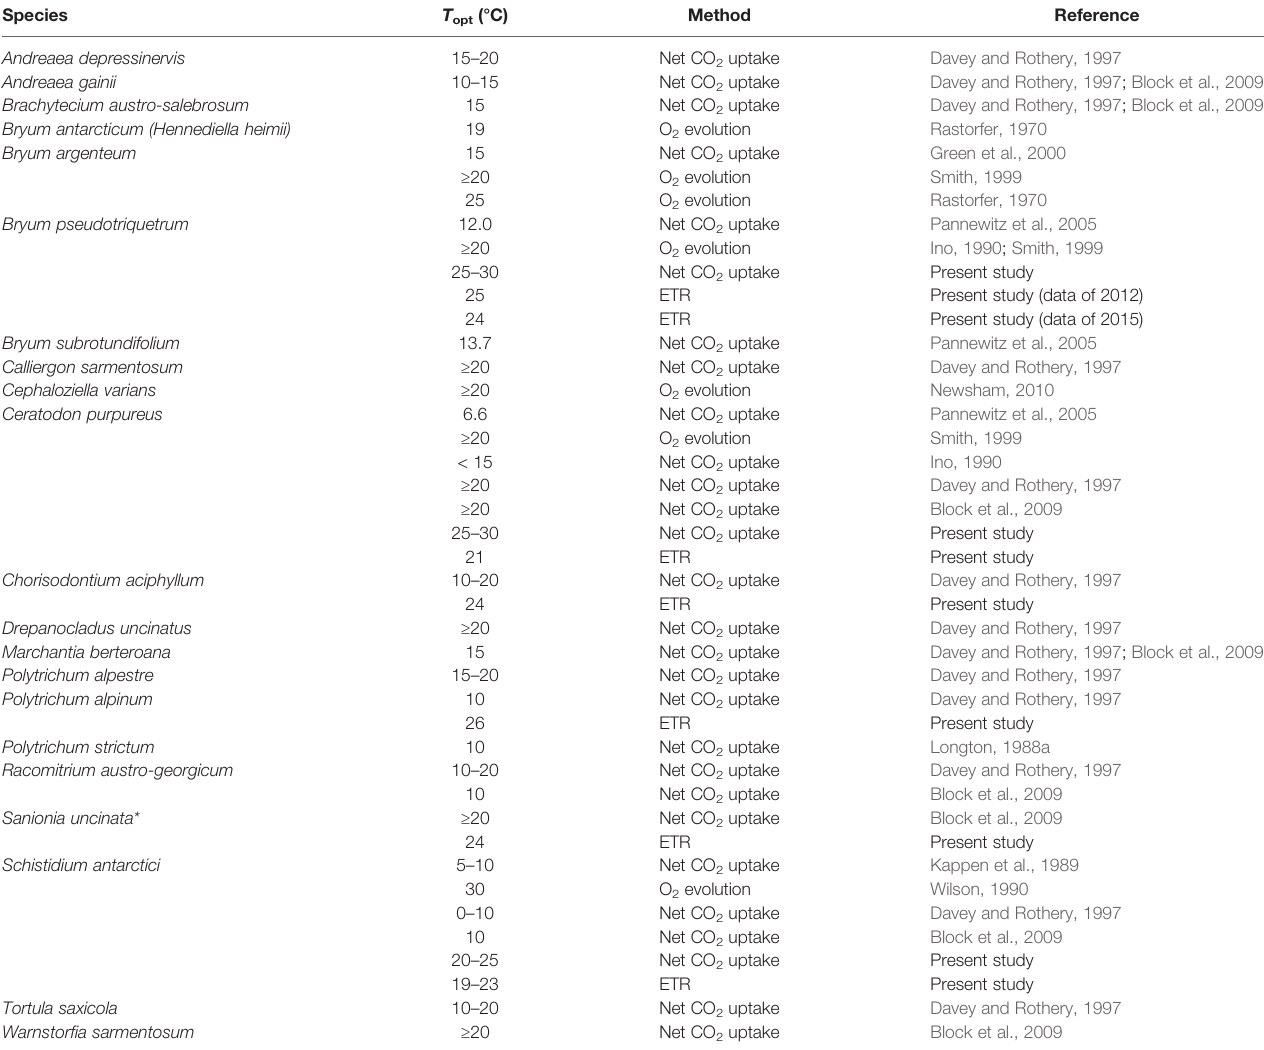
TABLE 5 | Temperature optimum ( T opt ) for photosynthesis for a range of Antarctic bryophytes measured under fi eld and laboratory conditions and as CO 2 assimilation, O 2 evolution, or ETR.